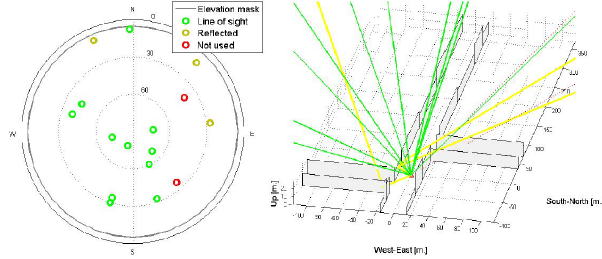
Figure 10: Number of satellites visible, satellites with direct line of sight, signals reflected, not used and used in the position esti- mation (left). EDOP, NDOP, HDOP, VDOP and PDOP during the same 2 hours and 40 minutes (right).